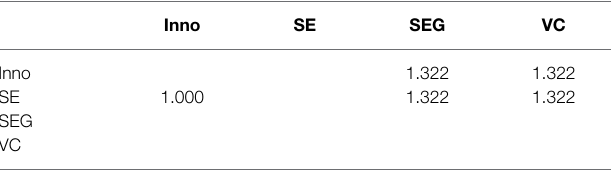
TABLE 5 | Collinearity statistics (inner-VIF